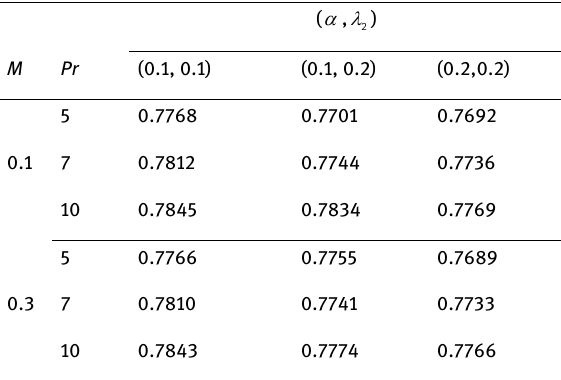
Table 3: HAM values of Nusselt number { − θ (cid:48) (0, ξ ) } for different val- ues of magnetic parameter M , second grade viscoelastic parameter α and second order slip parameter λ 2 , with all other parameters fixed and with order of approximations of